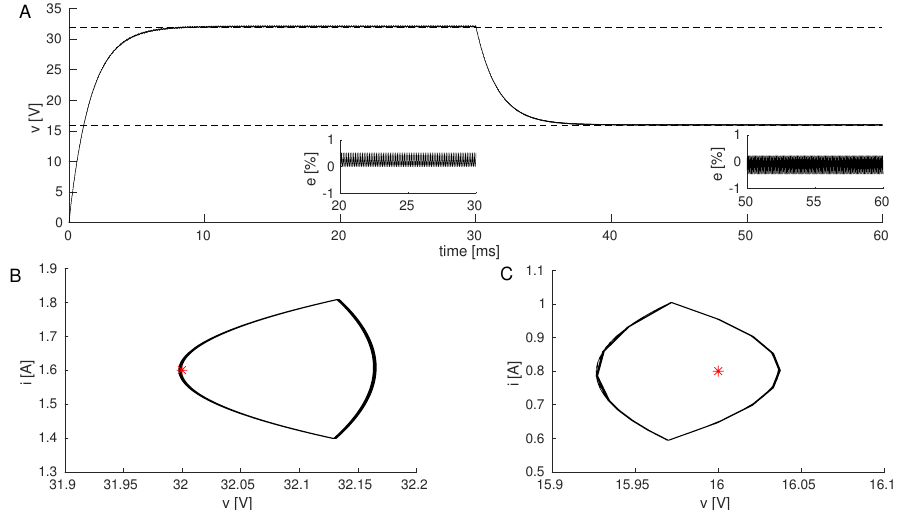
Figure 2. ( A ) Time trace of the voltage in the capacitor v . During the first 30 ms a ¯ v ref = 32 V is used, after this a drastic change to ¯ v ref = 16 V is applied (depicted in the dashed lines). The time trace of the steady state percentage error is also depicted in the insets for both values of ¯ v ref ; ( B ) Phase representation of the steady state for ¯ v ref = 32; ( C ) ¯ v ref = 16, with the equilibrium point indicated by the red star. Simulations were performed using MATLAB R (cid:13) with a fourth order Runge-Kutta algorithm with variable step and event detection to identify collisions with the hysteresis band. Steady state was considered after 20 ms of simulation time. Initial conditions were chosen as ( v , i ) = ( 0,0 ) . Other parameters as in the main text.